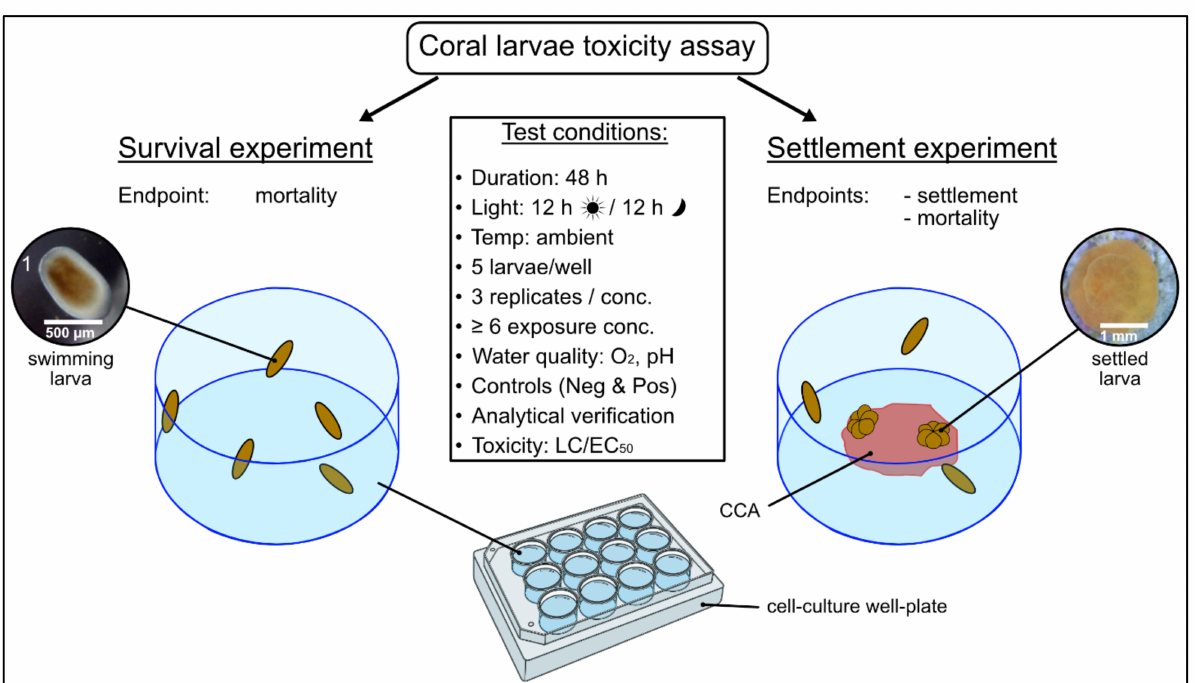
Figure 1. Schematic overview of the acute toxicity assay performed using coral larvae conducted in 12-well cell culture plates. The endpoint ‘mortality’ was assessed in the survival experiment, while ‘settlement’ (metamorphosis + attachment) was assessed additionally in the settlement assay. Planula larvae were exposed to the target compound for 48 h to assess acute toxic responses to the compound. A crustose coralline algae (CCA) chip was used to induce settlement. See Table S3 for more details on the exact condition during the experiments. 1 Photo courtesy of L.